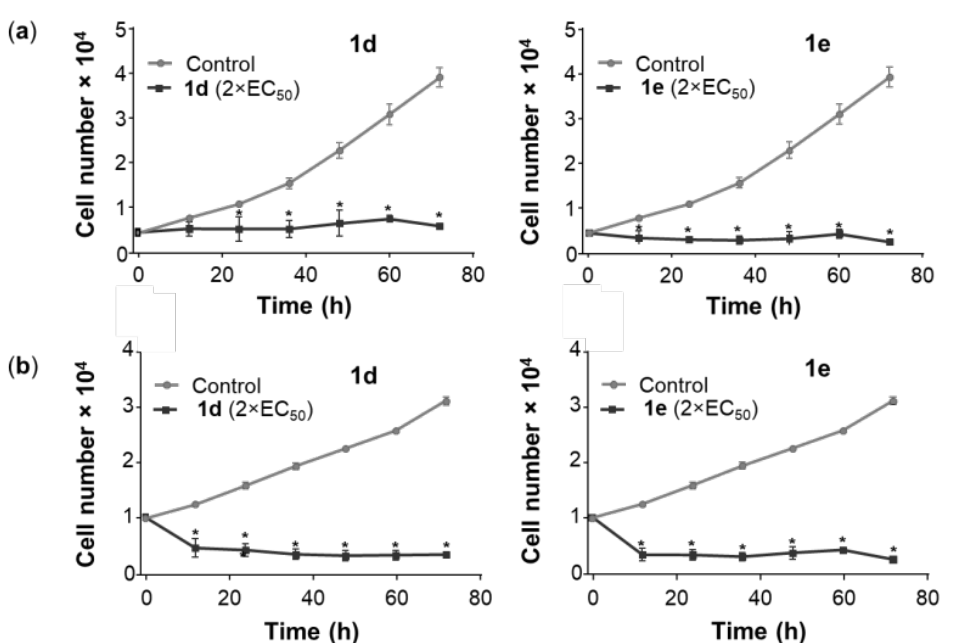
Figure 3. Time course cytotoxicity assessment of 1d and 1e in A549 and NCI-H522 cells. A549 cells and NCI-H522 were seeded in 96-well plates at 4000 and 10,000 cells per well, respectively, and incubated for 24 h at 37 ◦ C. ( a ) A549 cells were treated with 0.72 µ M of 1d and 0.64 µ M of 1e , while ( b ) NCI-H522 cells were treated with 0.56 µ M of 1d and 0.46 µ M of 1e , in both cases for 12–72 h. Vehicle control cells were treated with DMSO (0.5%). At the end of the treatment period, the cell number was determined by the SRB assay. The points represent the mean ± SEM ( n = 3). Data were analyzed using a two-way ANOVA coupled with a Bonferroni post hoc test. * Significantly different from control, p < 0.01. No significant differences were determined between each treatment point from 12 to 72 h.